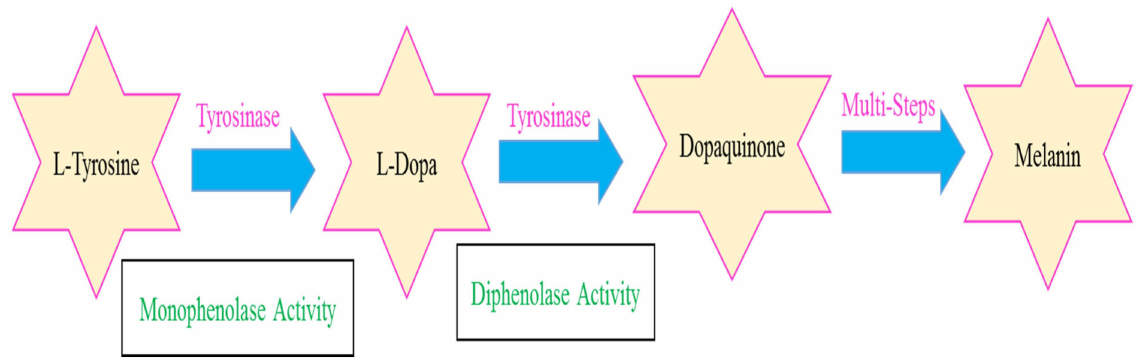
Figure 1. Tyrosinase-catalyzed biosynthesis of